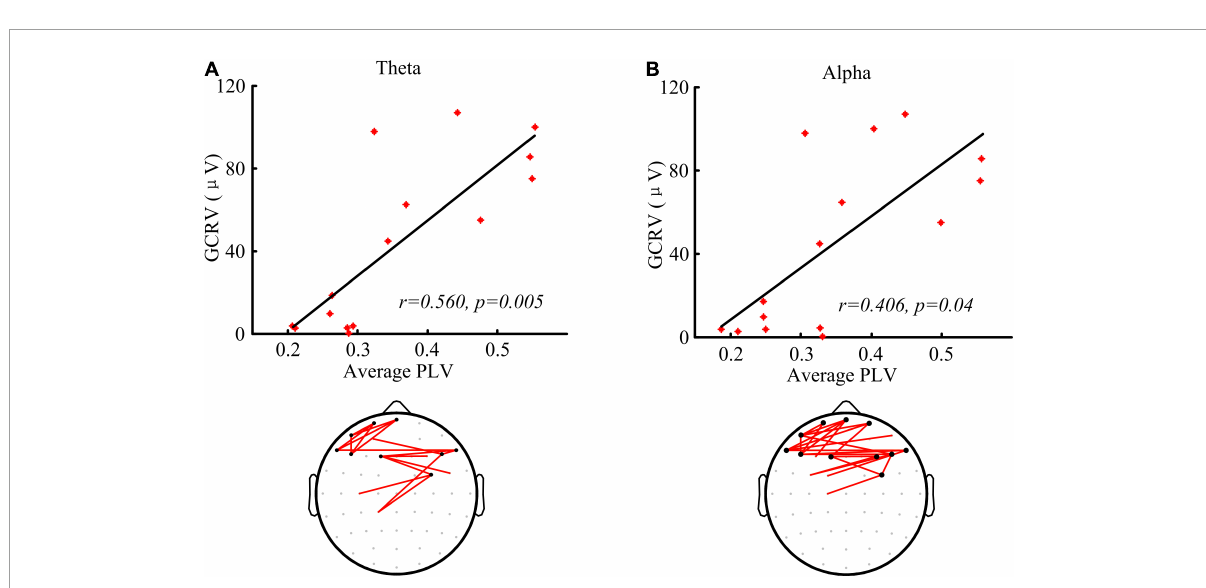
FIGURE4 Functional connectivity measured by PLV and the correlation with the global cortical reactivity values (GCRV). (A,B) Correlation (Kendall’s tau coefficient) of global averaged PLV at theta (A) and alpha (B) band with the patients’ GCRV. Bottom panel shows the connectivity (red lines) that significantly correlate with the patients’ GCRV. Black dots show electrodes associated with at least three red